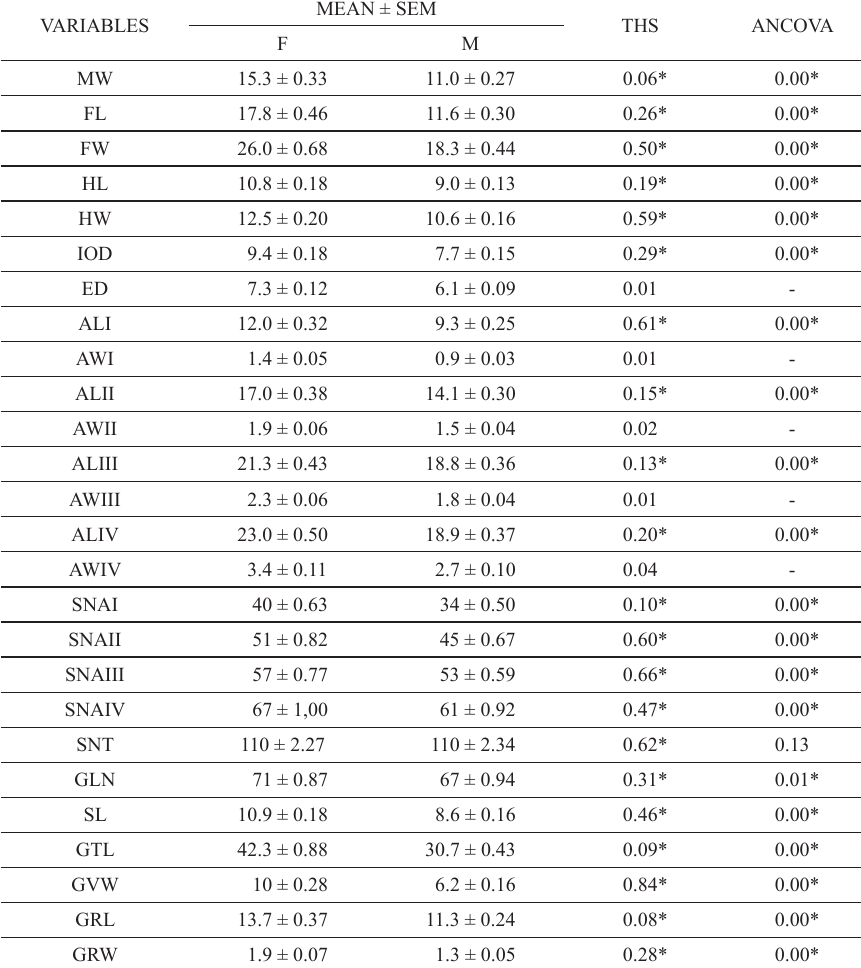
Summary of morphometric analysis of Lolliguncula brevis collected off Brazilian